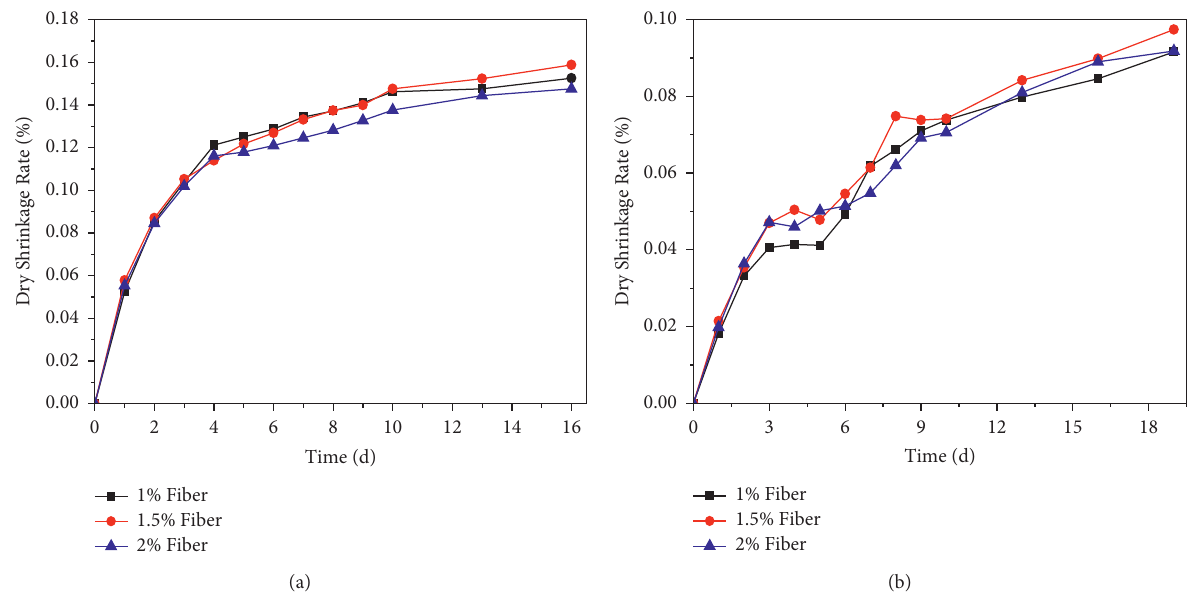
Figure 8: Drying shrinkage rate of mortar with different fiber contents under (a) RH � 40% and (b) RH �